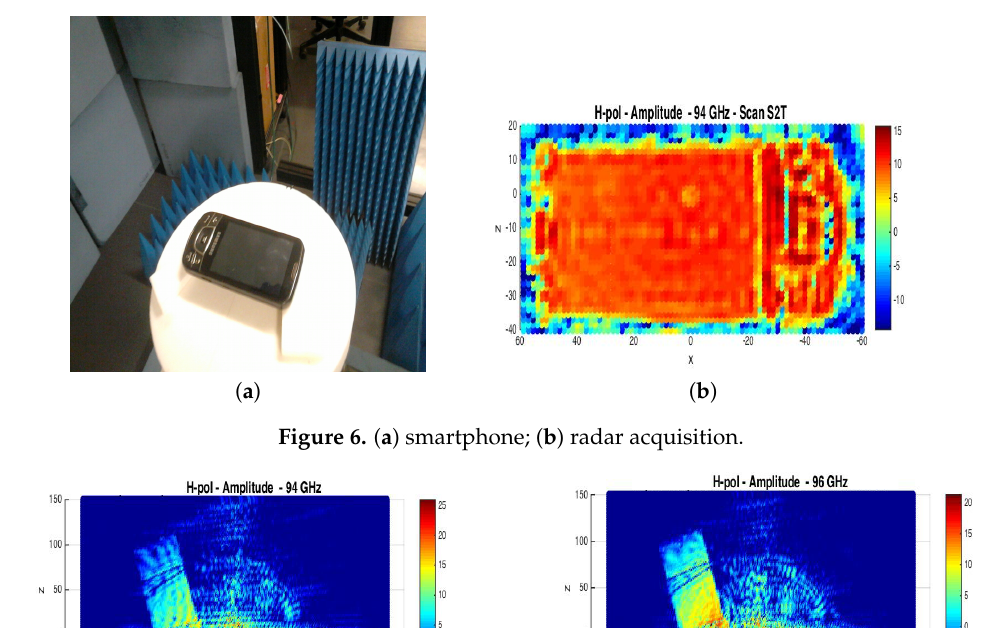
Figure 7. Scan amplitudes of a concealed gun, ‘H’ polarization: ( a ) 94 GHz; ( b ) 96